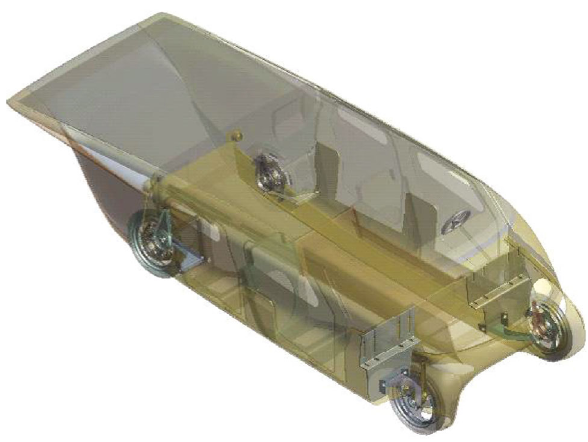
Figure 1: The Solar Cruiser Emilia 4.